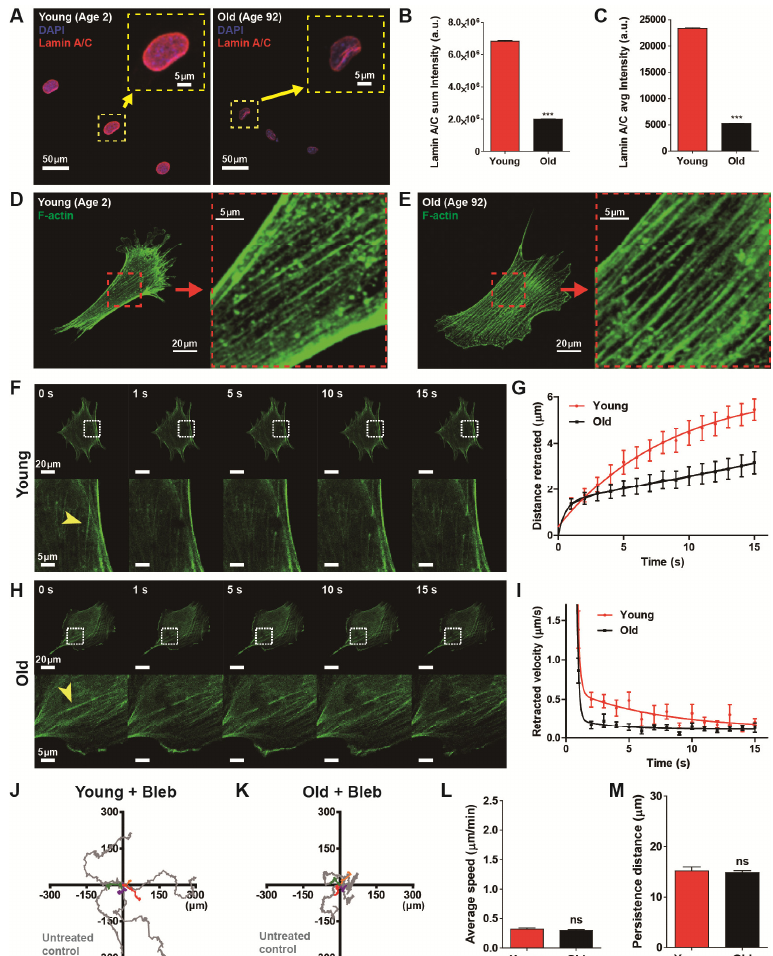
Figure 4. Actomyosin contractility determines age-dependent cell migration. ( A – C ) Di ff erential molecular contents of lamin A / C in young and old HDFs. High-throughput immunofluorescence analysis indicated enhanced molecular content of lamin A / C in the nuclei of young HDFs as compared with the nuclei of old HDFs ( A ). Insets show representative lamin A / C staining (red) along the nuclear boundary in HDFs. Statistical quantification revealed that lamin A / C expression in old HDFs decreased fourfold as compared with young HDFs ( B , C ). More than 2900 cells (young, 2956 cells and old, 4433 cells) were analyzed for each condition. ( D – I ) Biophysical measurement of actomyosin contractility by laser ablation-induced monitoring of F-actin retraction. Organization of actin stress fibers in young and old HDFs did not show any structural di ff erences ( D vs. E ). Monitoring of F-actin retraction after laser ablation of actin stress fibers in young HDFs and old HDFs ( F – I ). Arrowheads indicate the position of laser irradiation ( F , H ), where actin stress fibers were bifurcated immediately after laser stimulation and progressively retracted to opposite sides. Time-lapse monitoring displayed retraction distance and retraction speed in young HDFs ( n = 6) were greater than in old HDFs ( n = 11) ( G , I ). ( J – M ) Alteration of cell motility by inhibition of myosin activity. Cell motility was reduced by treating cells with blebbistatin, a myosin II ATPase-inhibitor, in young and old HDFs. Note that time-lapse monitoring of cell migration was performed for 8 h, 1 h after addition of 2 µ M blebbistatin. Representative cell trajectories of young and old HDFs indicated cell migration was reduced by a decrease in myosin activity ( J , K ). Inhibition of myosin activity impedes cell migrationas compared with the results of Figure 1 by decreasing cell migration rate ( L ) and migratory persistence ( M ), regardless of aging. More than 20 cells were analyzed for each condition. In panels ( L ) and ( M ), error bars represent S.E.M. of averaged values and statistical significance was assessed by the unpaired t -test. *** p < 0.001; ns, no significance ( p >